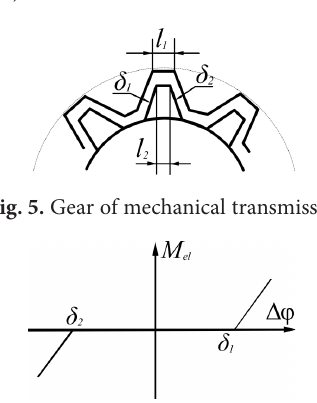
Fig. 6. Nonlinear dependence of elastic moment in the presence of the gap The gap size δ 1 and δ 2 depends on the starting position of the transmission. Usually accepted δ 1 =δ 2 =δ/2, where δ= l 1 – l 2 ,